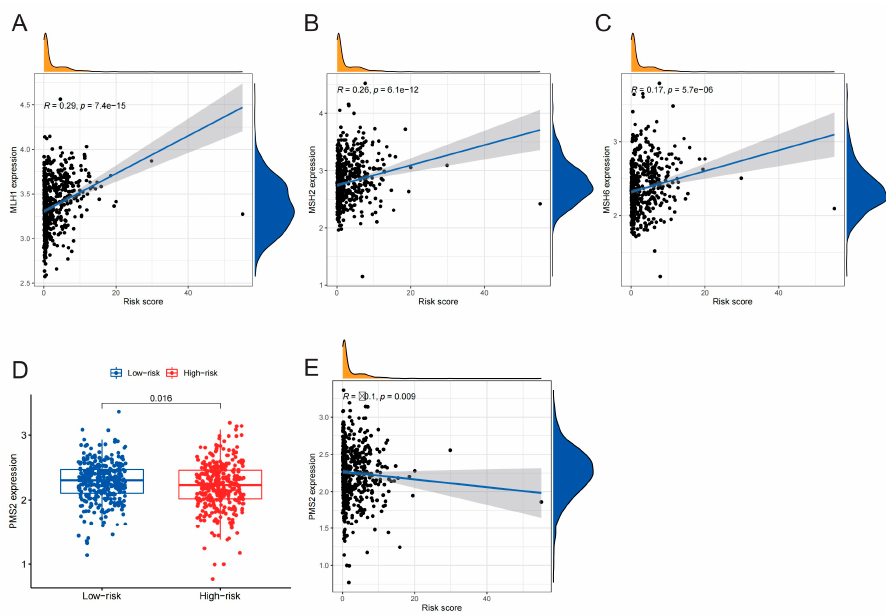
Figure A7. The box plot of the expression of PMS2. Figure A7. ( A–E ) The box plot of the expression of